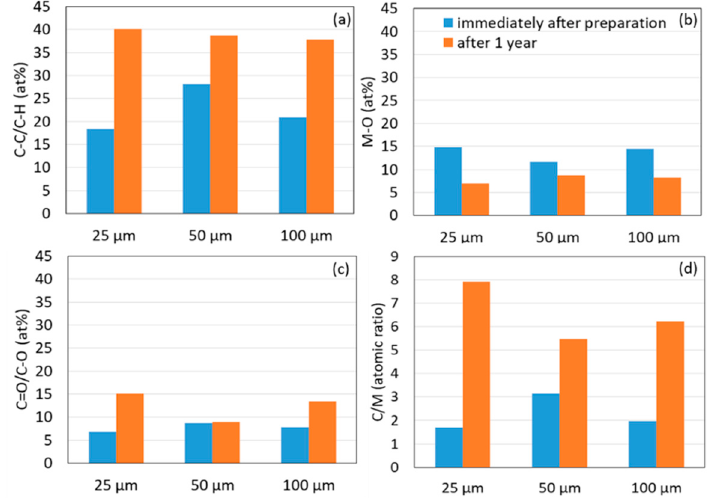
Figure 4. Deconvoluted XPS spectra of C 1 s ( a ), O 1s ( b ), Fe 2 p 3/2 ( c ), Cr 2 p 3/2 ( d ) laser-textured AISI 316L surface ∆ x = ∆ y = 50 μ m stored in ambient conditions immediately after preparation.